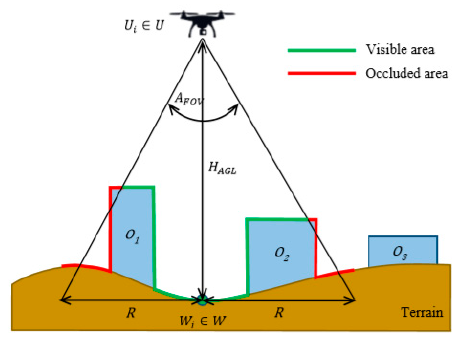
Figure 2. Coverage of the area by a sensor of an unmanned aerial system (UAS).